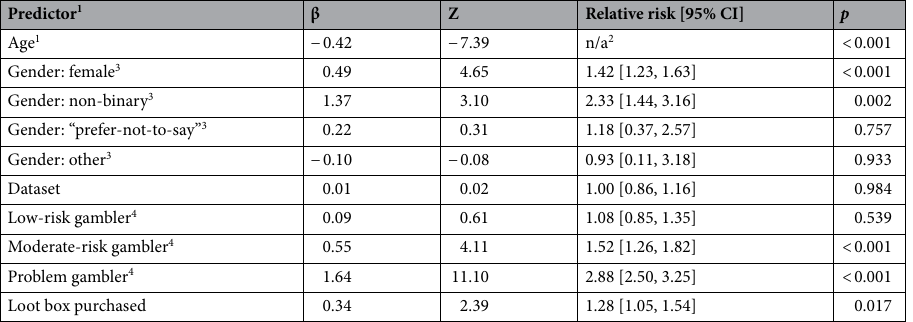
Table 3. Binomial linear regression results including age as a covariate, and problem gambler status, gender, and dataset as factors. 1 Age converted to Z-score to generate β. 2 Relative Risk inappropriate for age as a continuous covariate. 3 Comparison group: male. 4 Comparison group: Non-problem